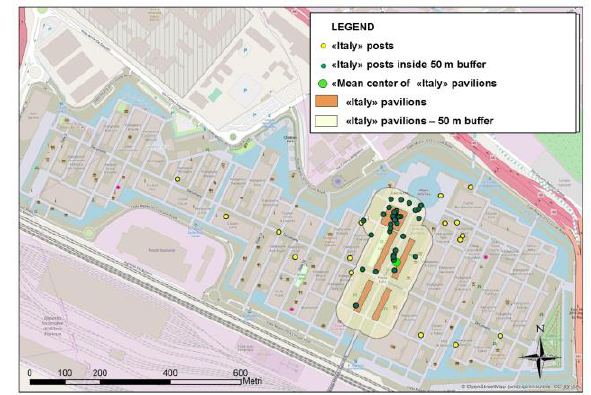
Figure 4. Example of results of the two-step ‘PLACE’-Buffer procedure for the semantic validation of the posts (case: Italy pavilions); green dots represent the validated posts